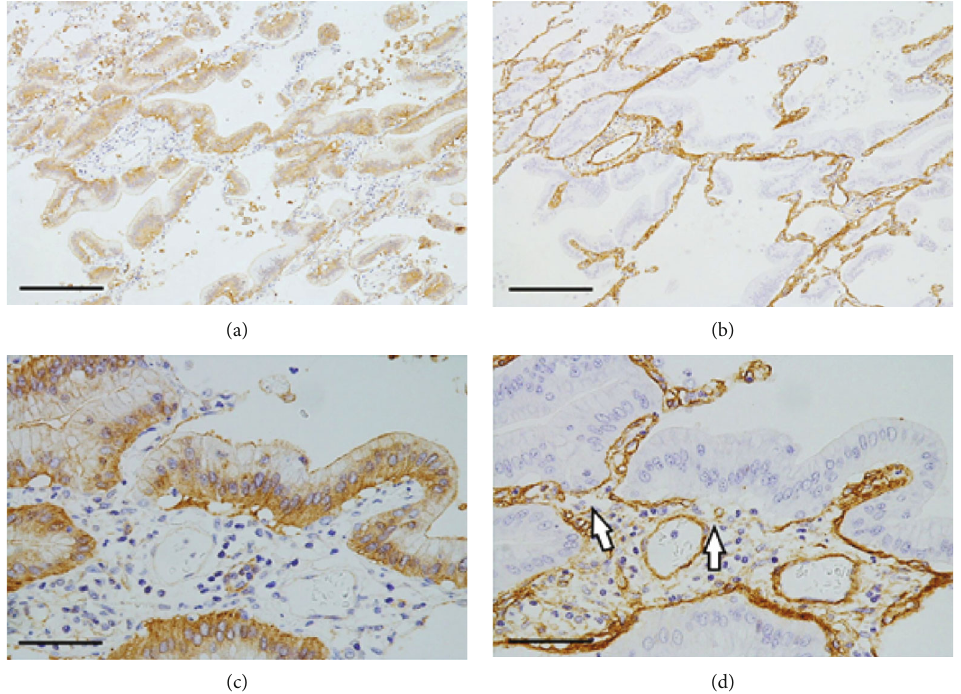
Figure 5: ANX A2 and collagen IV immunostaining of the lepidic or papillary component of the left lung tumor. (a) Tumor cells exhibit cytoplasmic ANX A2 positivity on the basal side. ANX A2 immunostain, scale bar: 400 μ m. (b) A linear positive collagen IV reaction corresponding to the basement membrane is seen on the surfaces of both alveolar and vessel walls. Collagen IV immunostain, scale bar: 400 μ m. (c) Detached tumor cells also exhibit cytoplasmic ANX A2 positivity on the basal side but not at the cell – cell borders. Positive staining is also observed in the exfoliative gap. ANX A2 immunostain, scale bar: 100 μ m. (d) Weak or no collagen IV positivity is visible at the detachment site (arrows). Collagen IV immunostain, scale bar: 100 μ